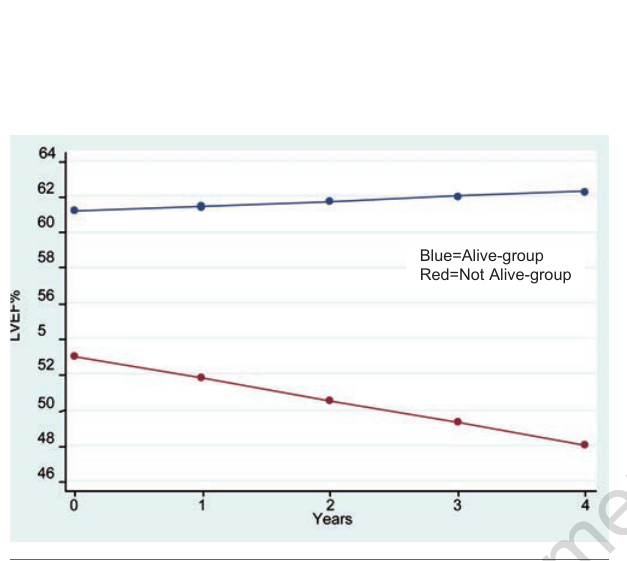
Figure 7. Estimated profiles from the fitted GEE model for the two patient-groups: the not alive (red color) versus the alive- group (black color) (Maggio et al. 2012, submitted).